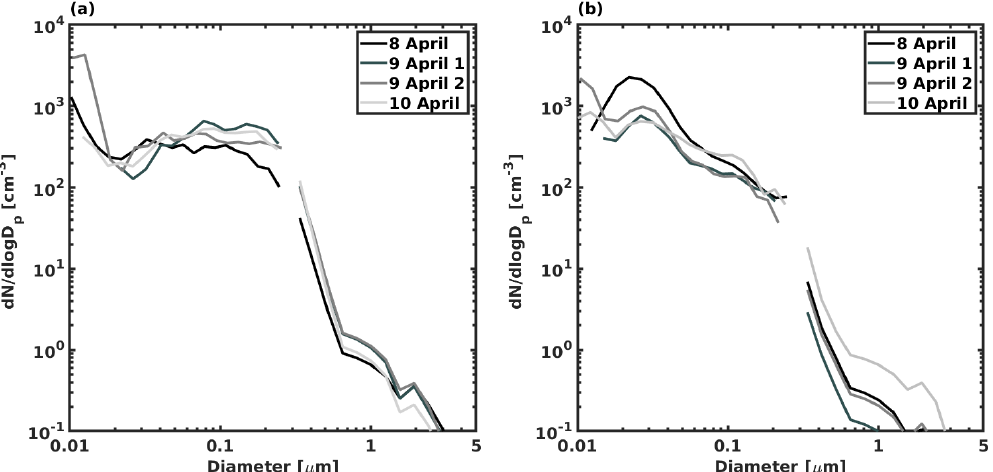
Figure 4. Evolution of the mean aerosol size distribution in Case study I for (a) middle and (b) upper layers. Minimal change in the size distribution during 3 consecutive days implies that the middle layer did not mix with surrounding air. Upper layer does show changes over time, suggesting some